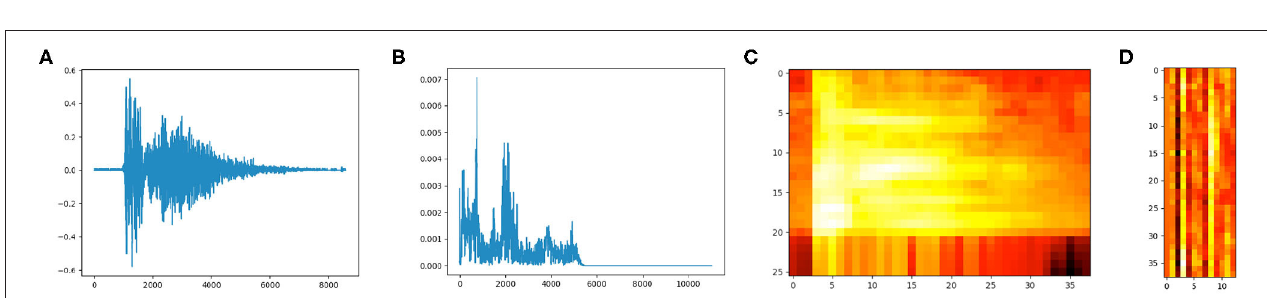
FIGURE 3 | Workflow for cough audio processing. For segmentation phase, predefined thresholds can be chosen based on the physiology of cough sounds. The raw recorded sounds contains a lot of silent fragments (with low intensity) and background noise. Therefore, silence removal phase is required for saving storage space. For signal quality check, an estimate of the signal-to-noise ratio (SNR) can be computed by taking the ratio of the power of the cough part of the signal to the ratio of the rest of the signal.